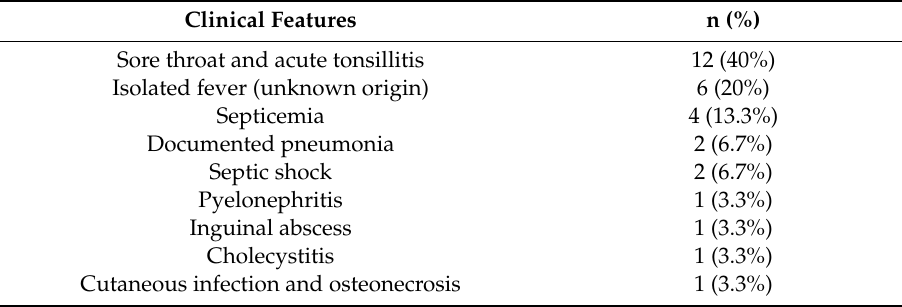
Table 1. Clinical features of the study sample at hospital